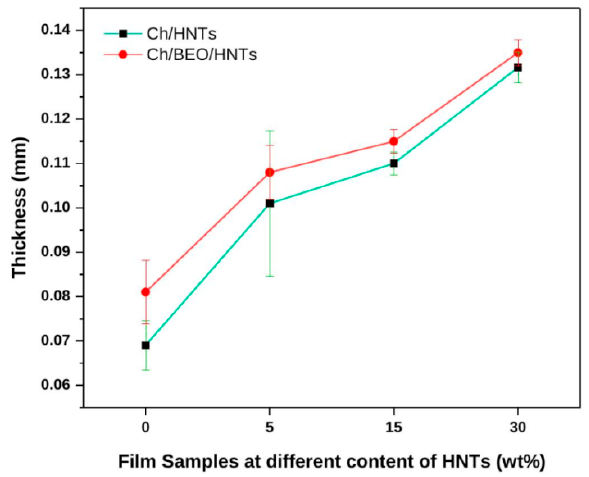
Figure 1. Thickness of Ch films formulated with HNTs and BEO.